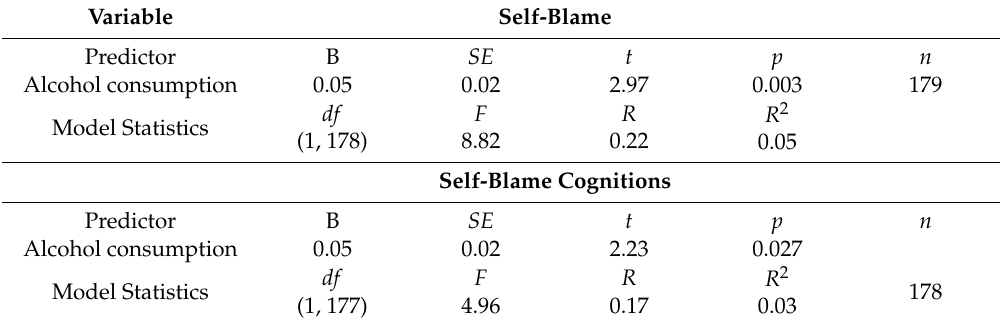
Table 5. Regression Analysis of Study